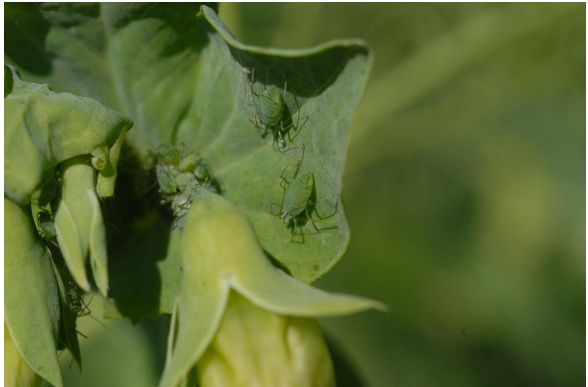
Figure 3 Aphids on the pea stipule photographed by Anne Nissinen, Natural Resources Institute Finland